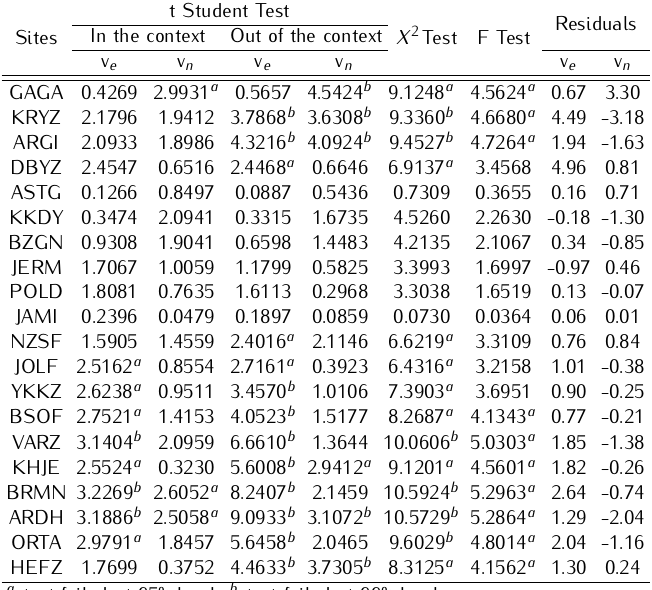
Table 6. Tests results (block B5). The results of the statistical tests for the GPS site data components. The sites passed from all the tests are the accepted data. The tests have been performed in two confidence levels (95% and 99%).